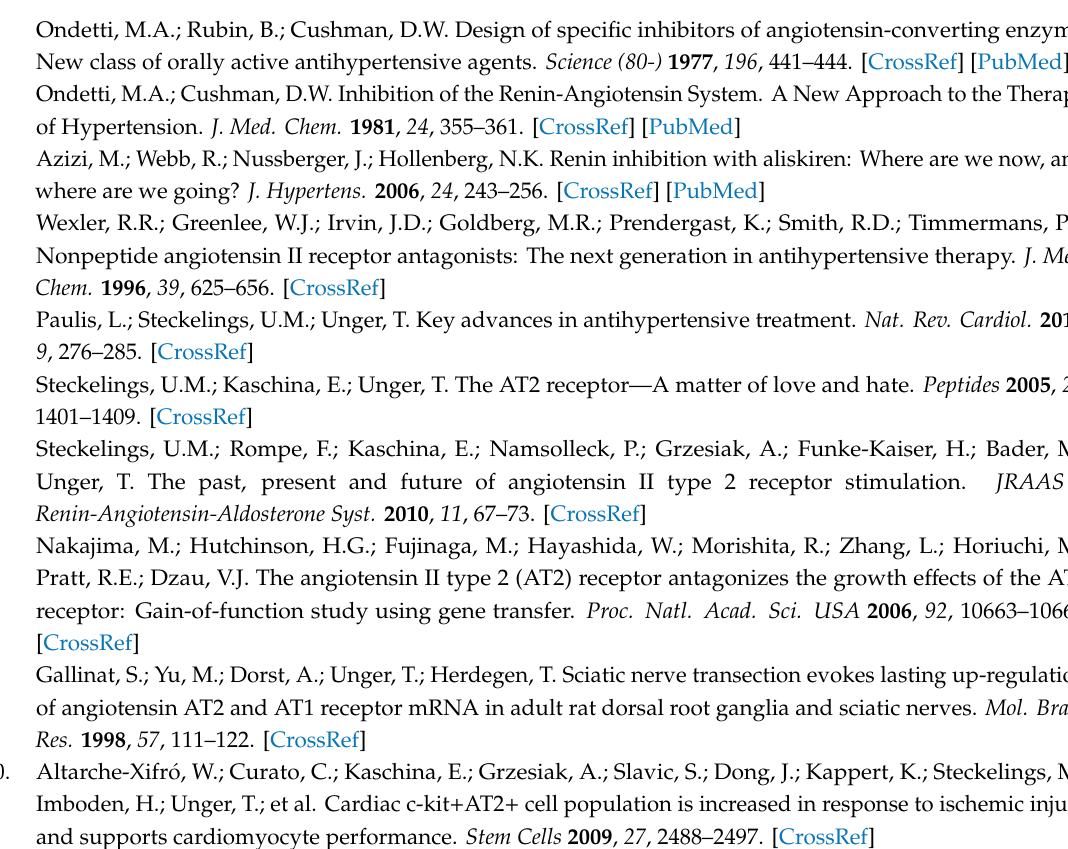
Figure S1: Comparison of the relative position of His 6 in AT1R and AT2R; Figure S2: Binding pocket of sarile in AT2R; Figure S3: Binding mode of compound 2 ; Figure S4: Binding mode of compound 3 ; Figure S5: Binding mode of compound 4 ; Figure S6: Binding mode of compound 5 ; Figure S7: Binding mode of compound 6 ; Figure S8: comparison of the C-terminus orientation of 4 with co-crystallized AT2R antagonists; Figure S9: Comparison of the binding modes of 6 and 11 ; Figure S10: Comparison of the binding modes of sarile in AT1R and AT2R; Figure S11: Sarile and Ang II C-terminal residues, overlaid with our docked compounds; Figure S12: Comparison between the docking poses of compound 6 based on sarile and on Ang II into the two angiotensin receptors; Figure S13: Average RMSD of each system simulated for 3 x 10 ns; Table S1: Relative binding a ffi nity for pairs of AT2R agonists with alternative starting